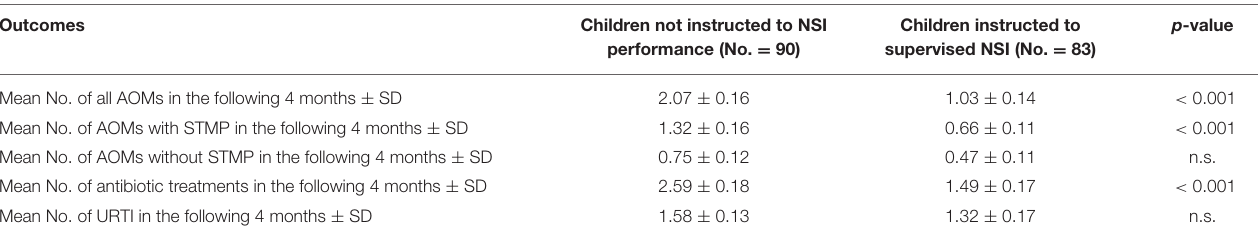
TABLE 2 | Clinical outcomes of the study